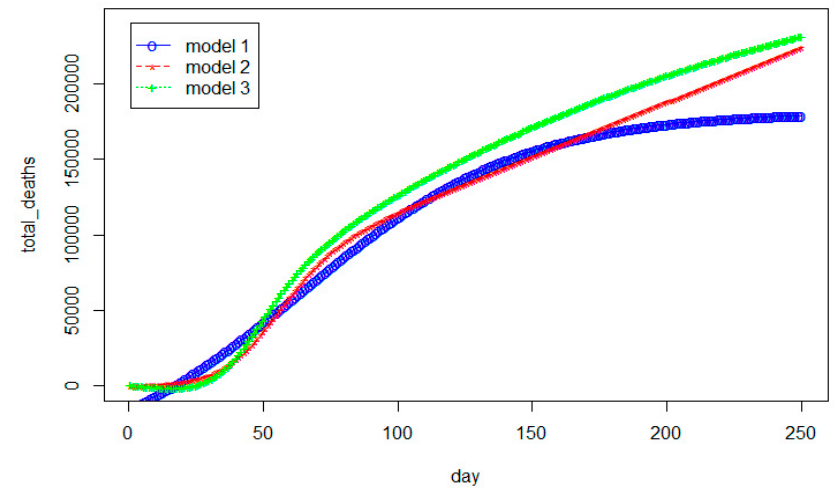
Figure 3. Daily number of infected cases over time for the United States.